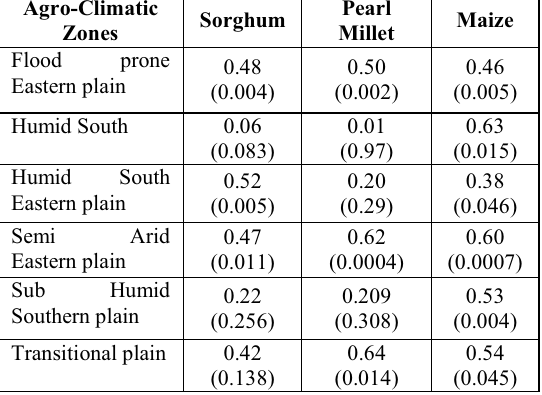
Table 1. Correlation coefficient between WRSI and actual yield, NB: Values in bracket are